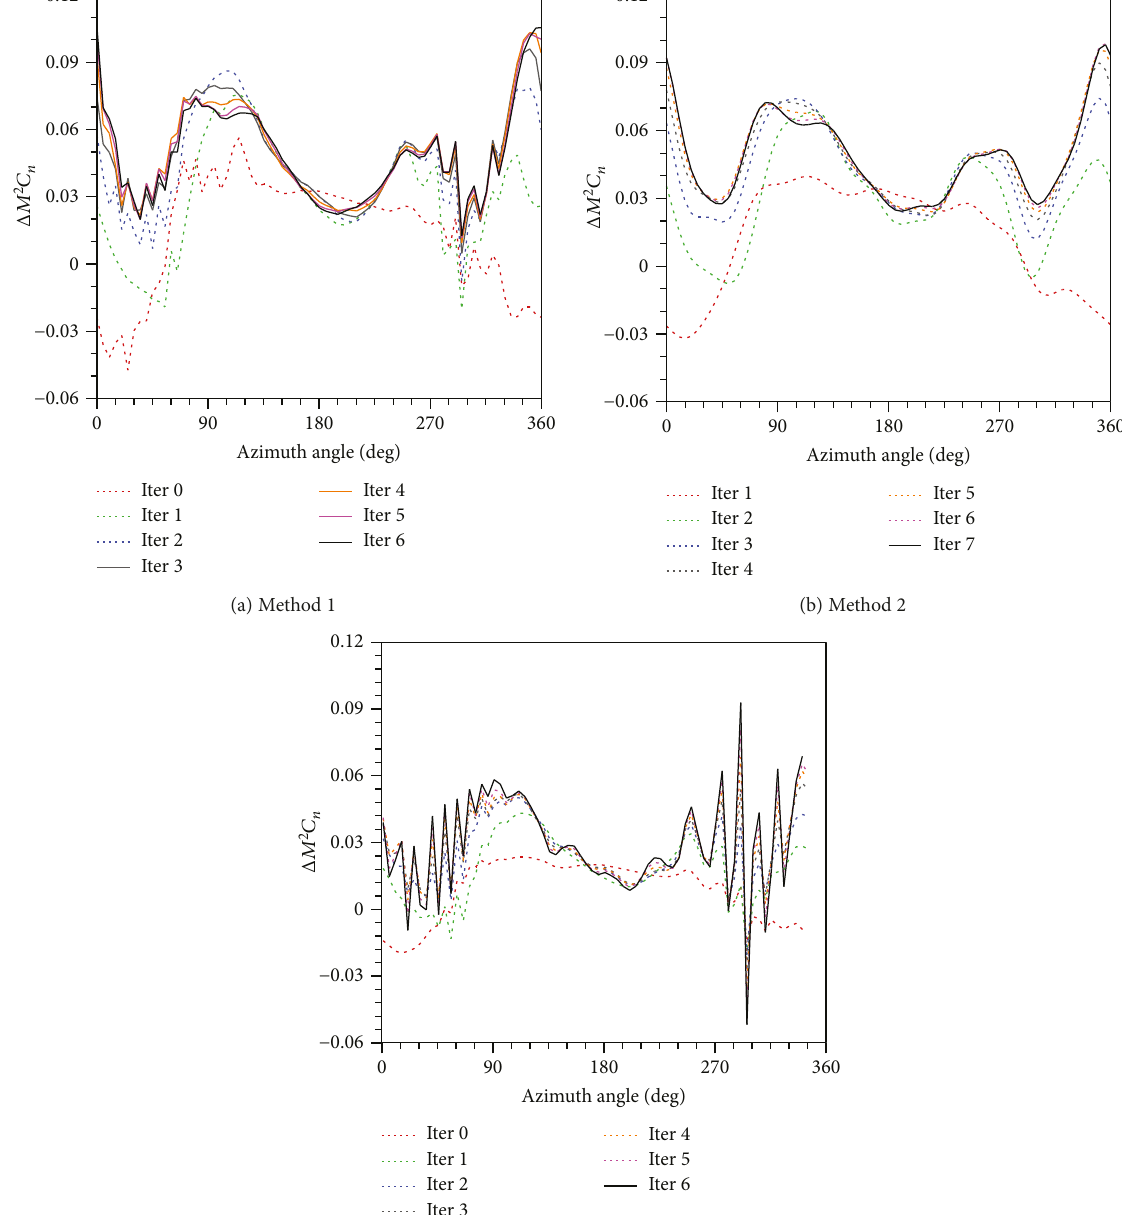
at r / R =0.87 with coupling n